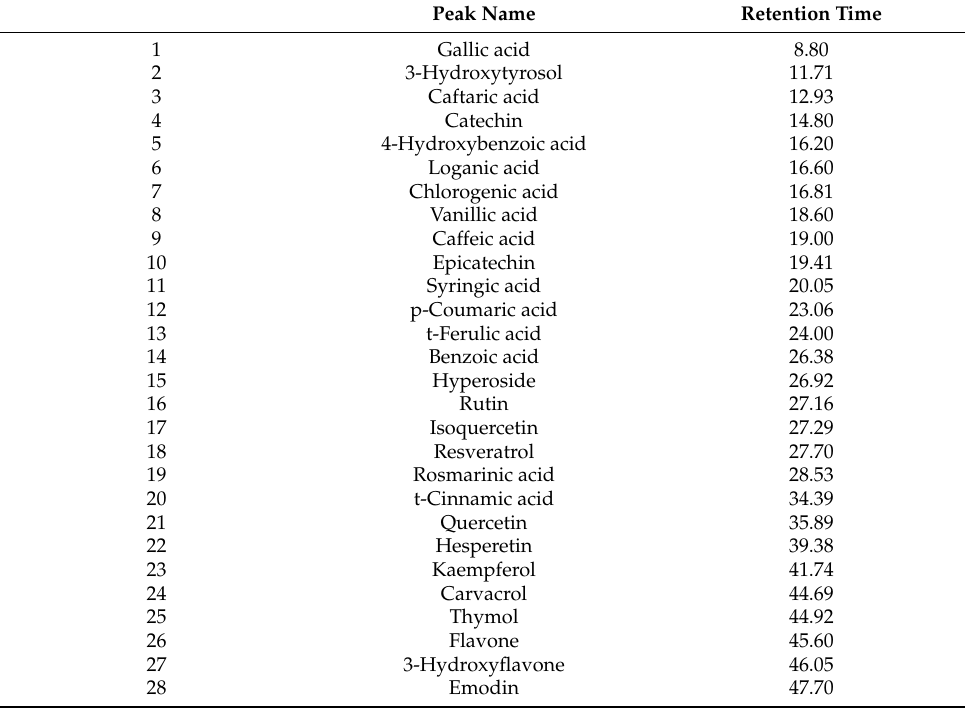
Table 4. Phenolic compounds